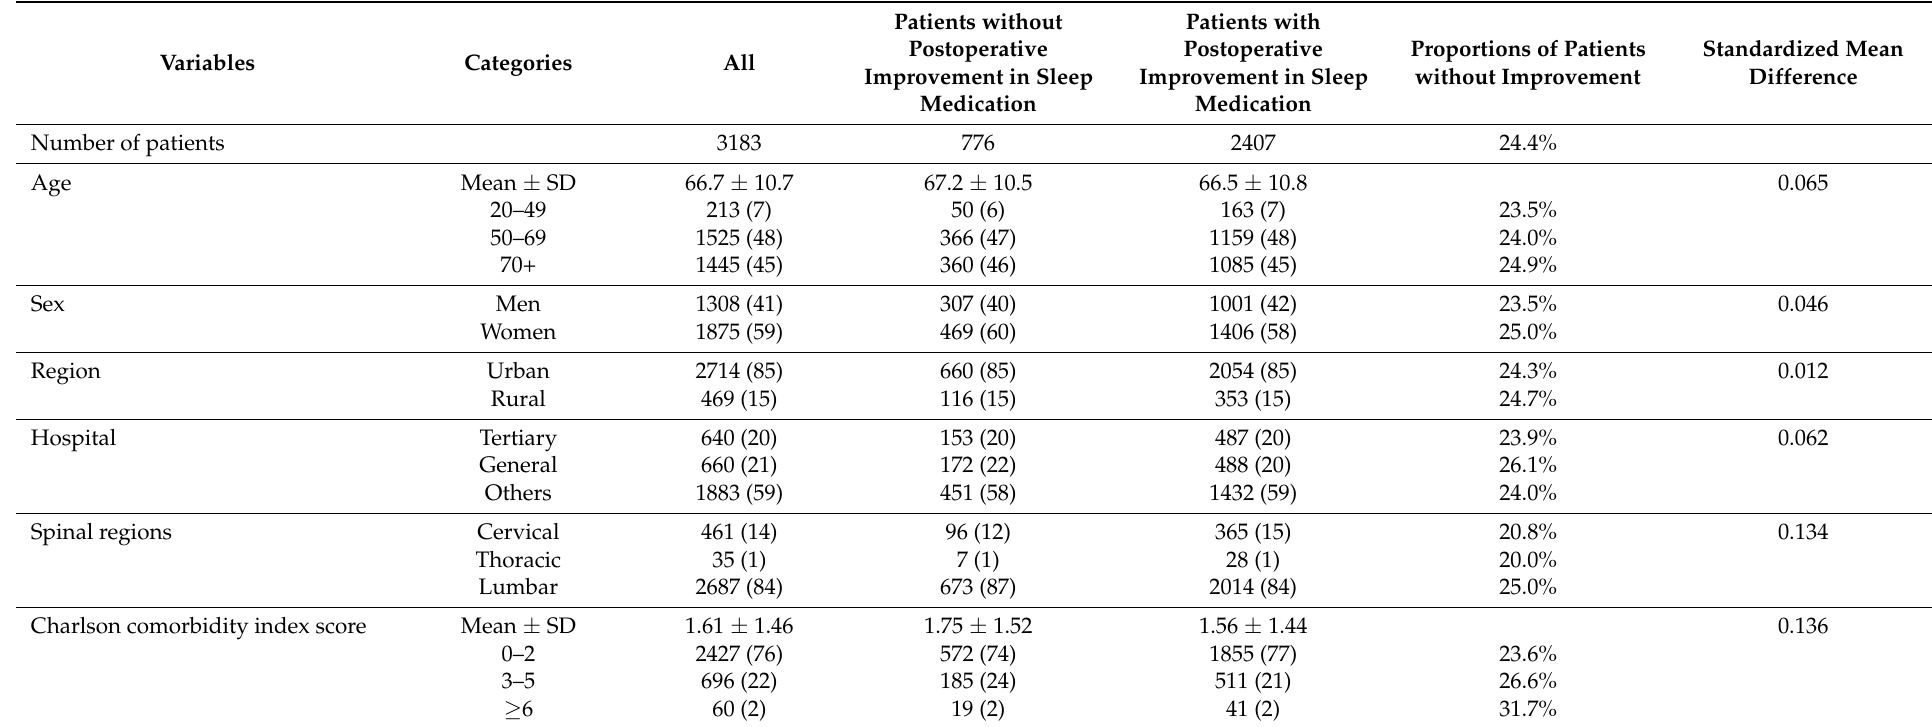
Table 1. Baseline characteristics of the cohort